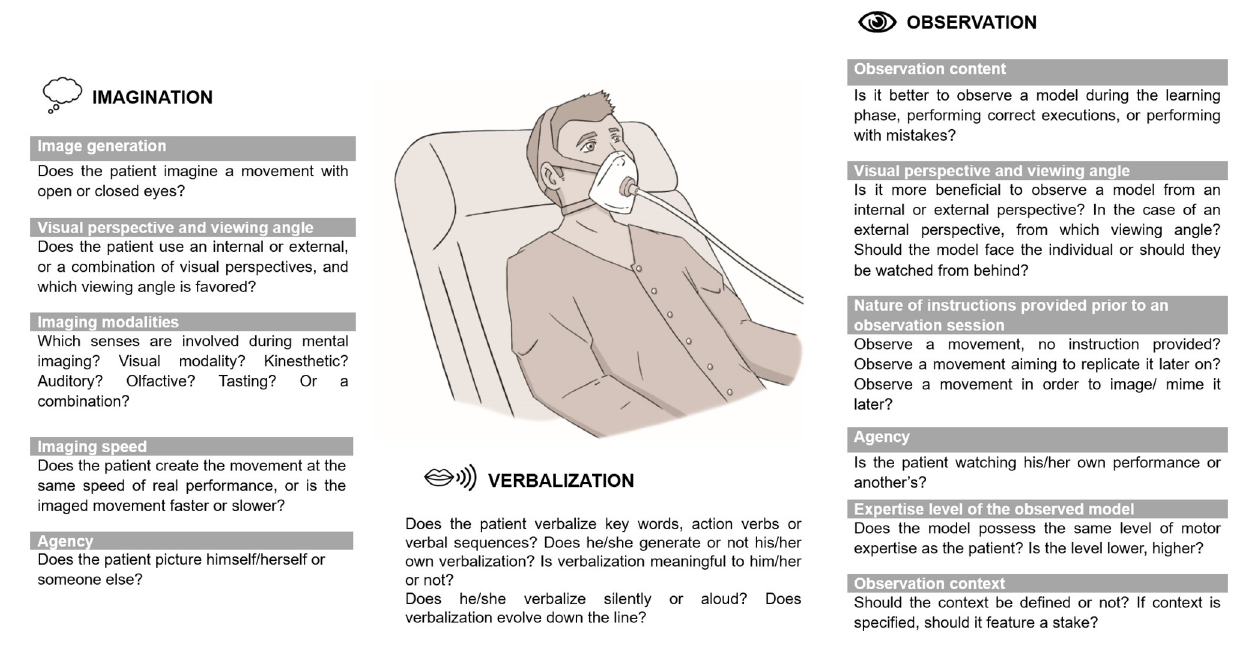
FIGURE 1 | Principles to be considered and tailored to patients’ individual needs for an efficient motor simulation